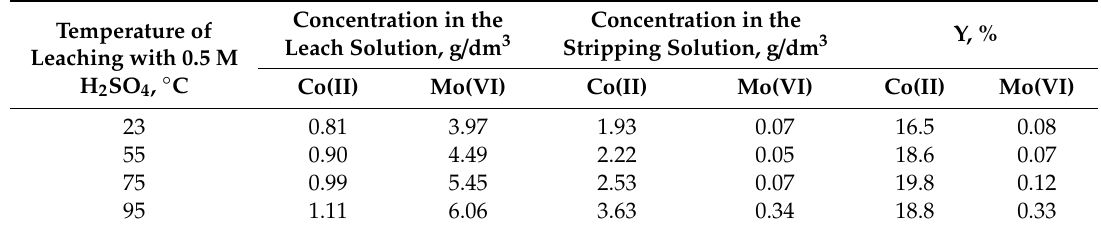
(leaching-precipitation-extraction-stripping). Temperature